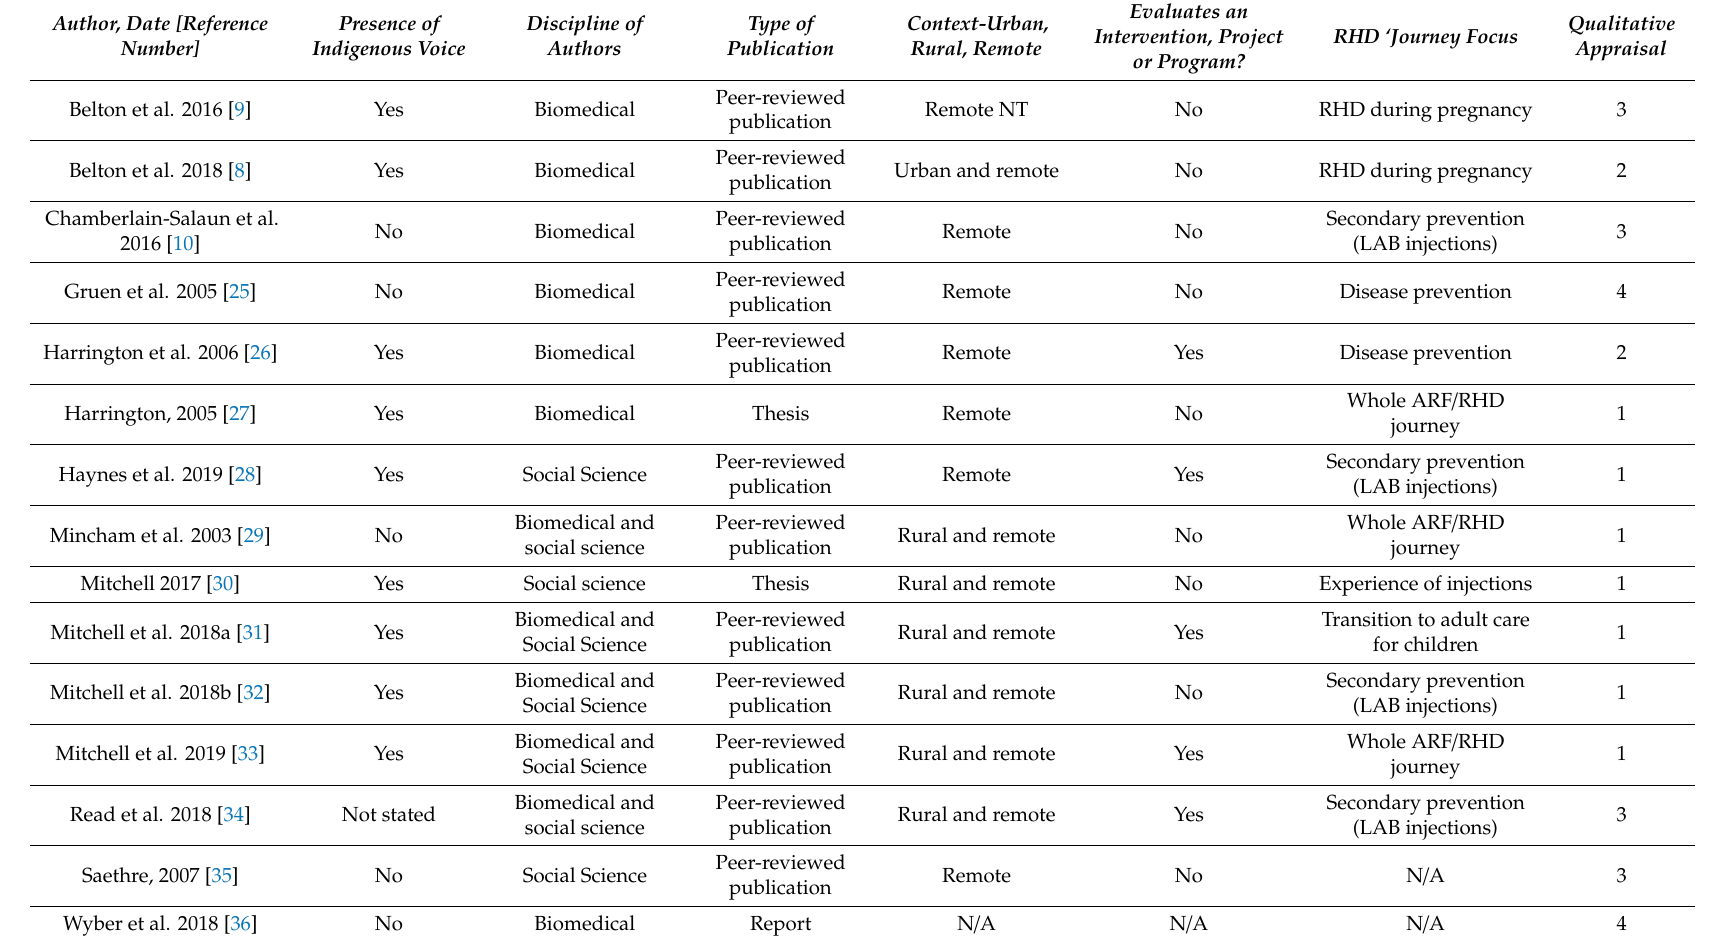
Table 1. A summary of the Australian literature included in this